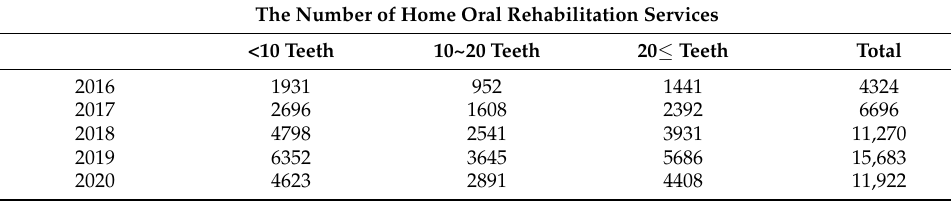
Table 10. The number of home oral rehabilitation